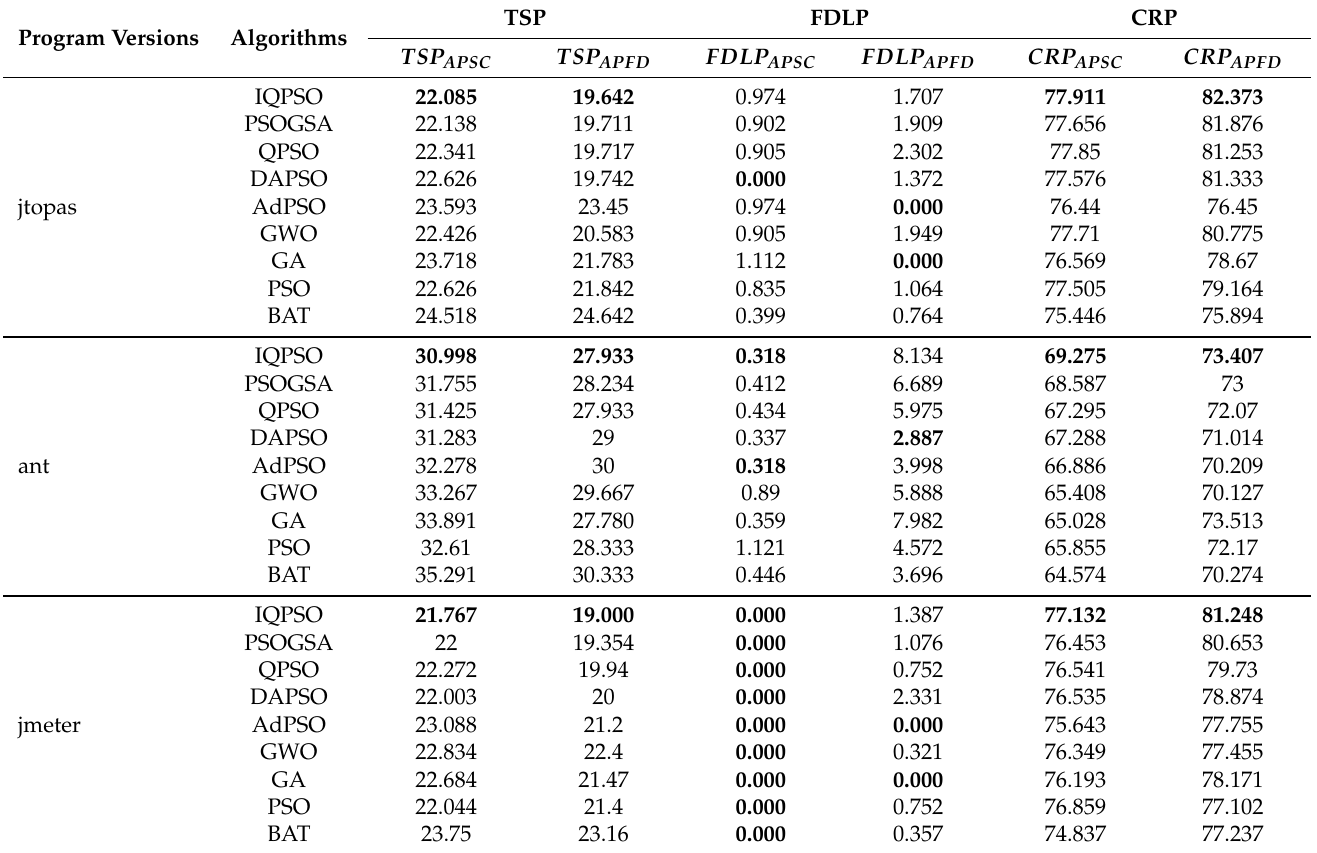
Table 6. Comparisons of the algorithms for TSR over fault and statement